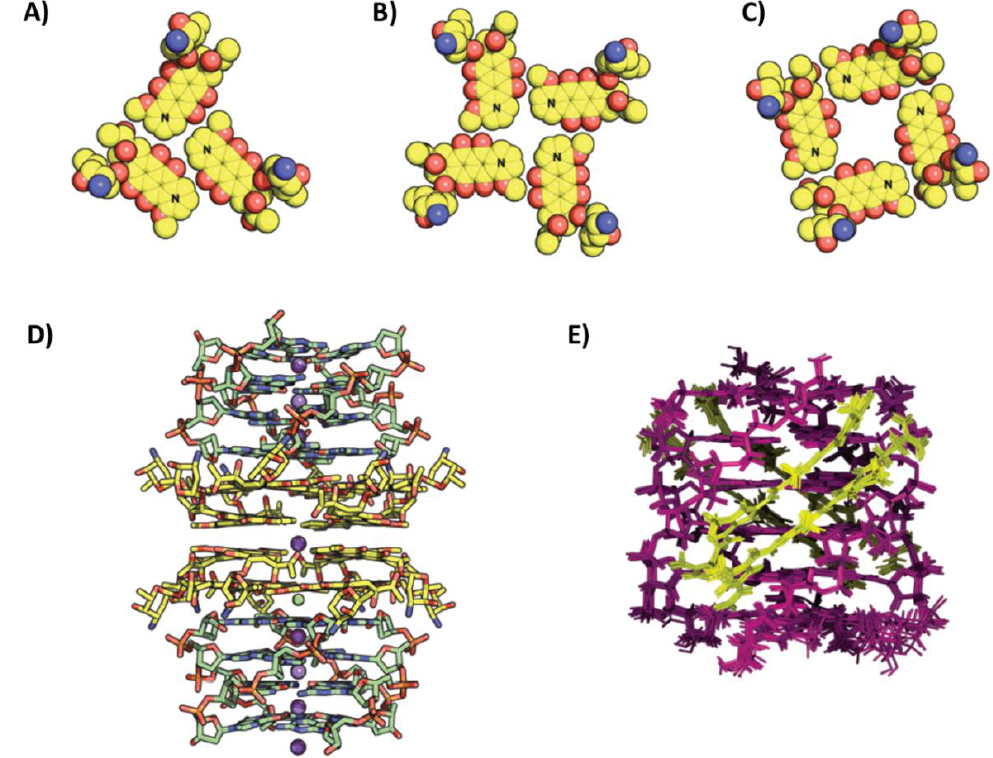
Figure 9. ( A ) Layer of daunomycin molecules in complex with the tetramolecular parallel G-quadruplex o-tel6 of sequence d(TGGGGT), as obtained by X-ray crystallography [76]. ( B , C ) Different layers of daunomycin molecules in complex with the tetramolecular parallel G-quadruplex o-tel4 of sequence d(GGGG), as obtained by X-ray crystallography [77]. ( D ) Crystal structure of the complex between the tetramolecular parallel G-quadruplex o-tel4 of sequence d(GGGG) and daunomycin [77]. G- quadruplex units are 5′–5′ stacked. ( E ) NMR structure of the complex between the tetramolecular parallel G-quadruplex o-tel6 of sequence d(TGGGGT) and distamycin [78] . 5′ - and 3′ -ends of the G-quadruplex are at the top and bottom, respectively. Adapted with permission from refs. [76–78], Copyright 2003 American Chemical Society and Copyright 2012 Oxford University Press and Copy- right 2007 American Chemical